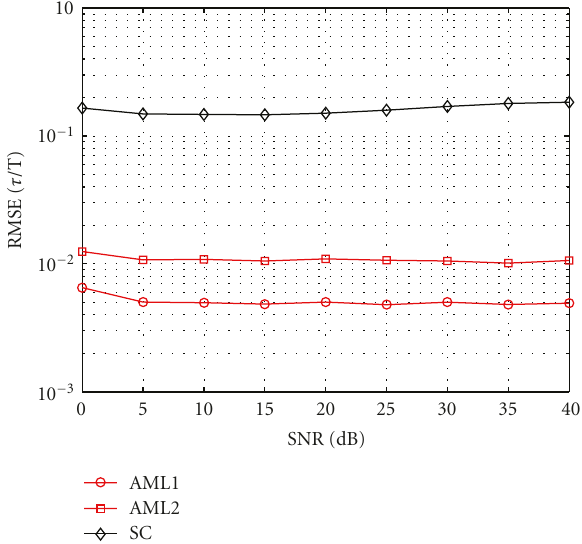
Figure 5: Performance of the considered ST estimators in ITU Vehicular A multipath